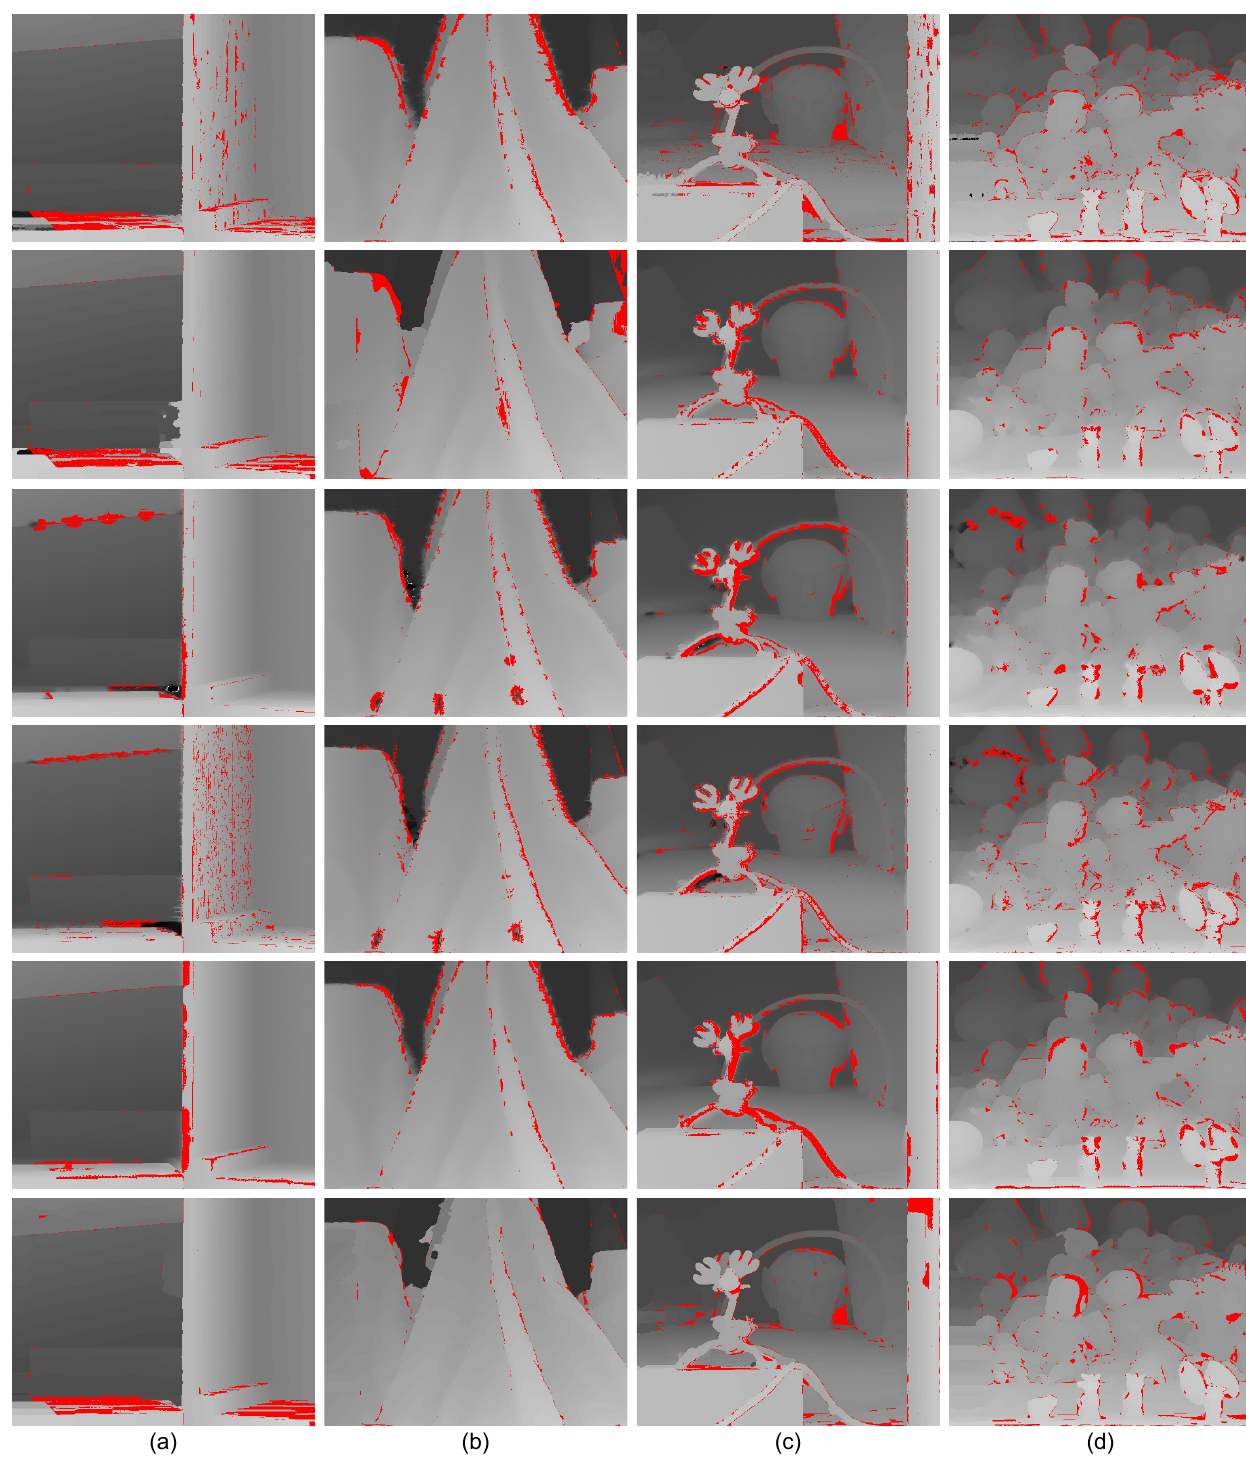
Figure 15. Evaluation results with the state-of-the-art “fused” scheme-based algorithms on the Middlebury extension datasets. ( a ) Wood1; ( b ) Cloth4; ( c ) Reindeer; ( d ) Dolls. Each column from top to bottom is the results obtained from: Zhu et al. [20], Wang et al. [23], Yang et al. [52], Jaesik et al. [53,55], James et al. [54] and our method. Error pixels with absolute disparity error larger than one in non-occlusion regions are marked red. The percentages of error pixels are listed in Table